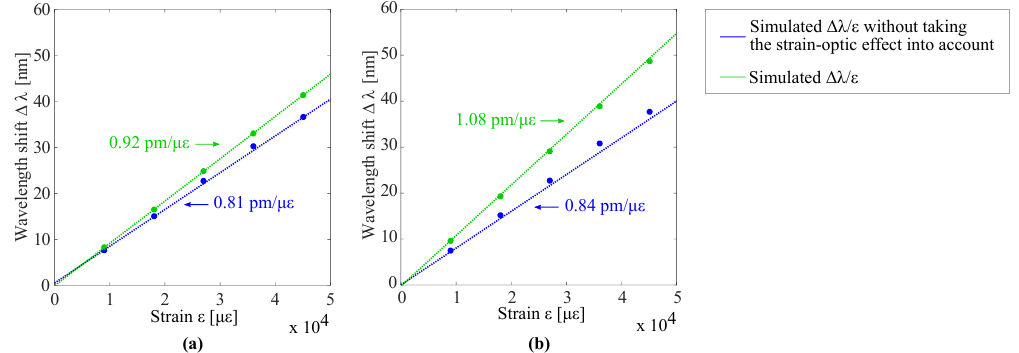
Figure 9. The simulated resonant wavelength shift ∆ λ as a function of the applied strain (cid:101) for the GMR grating in ( a ) OrmoCore and ( b ) EpoCore. The used grating parameters are listed in Table 1.